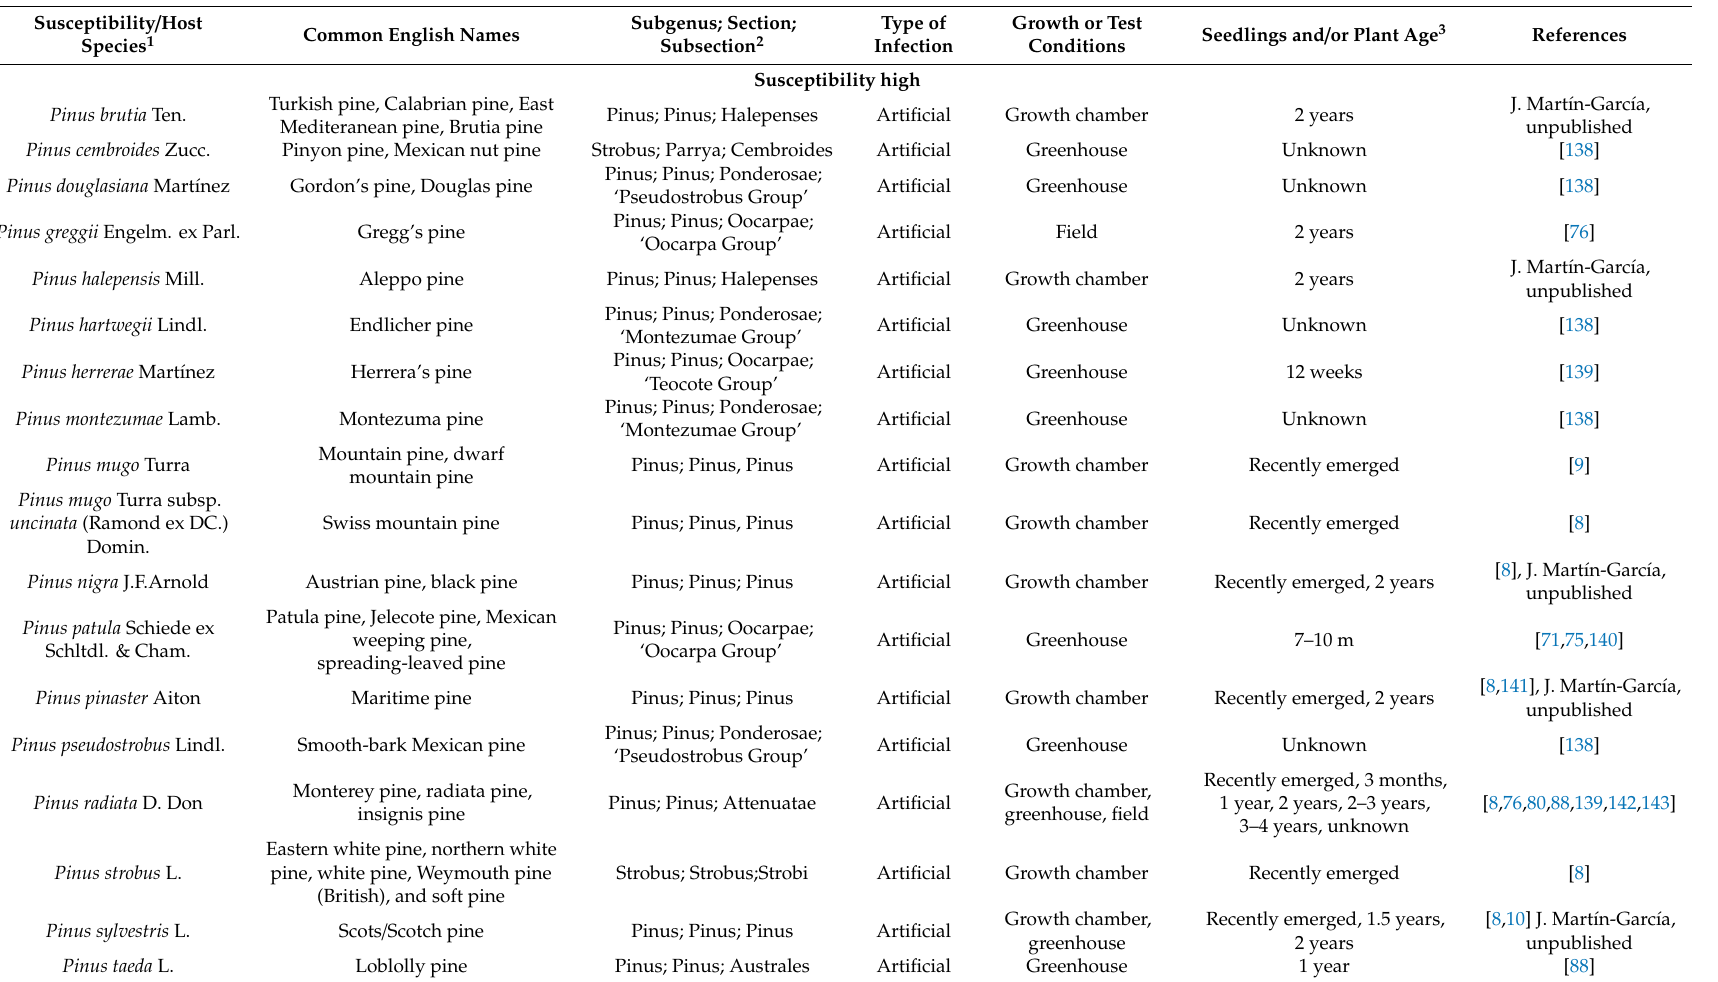
Table 3. Susceptibility list of Pinus species seedlings and young plants (recently emerged pine seedling and plants, ≤ 10 years old) to Fusarium